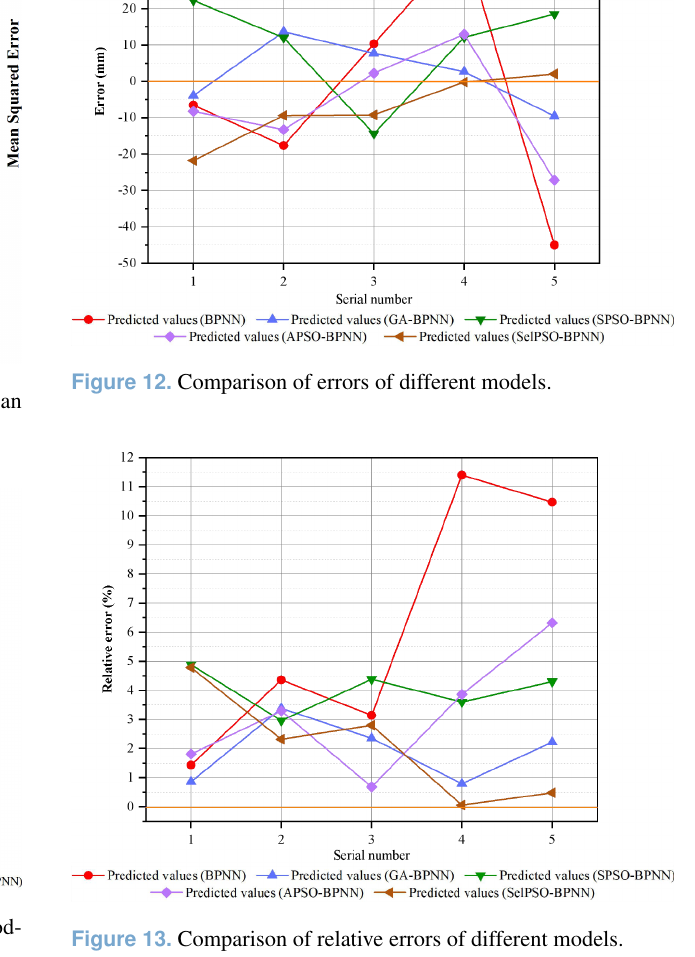
Figure 13. Comparison of relative errors of different